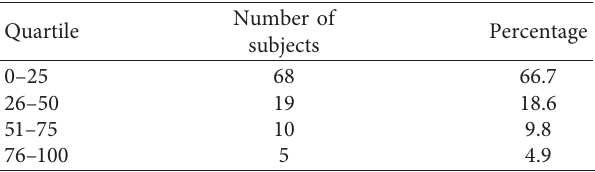
Table 1: Division into four quartiles of the anxiety level measured from 0 to 100 millimeters.